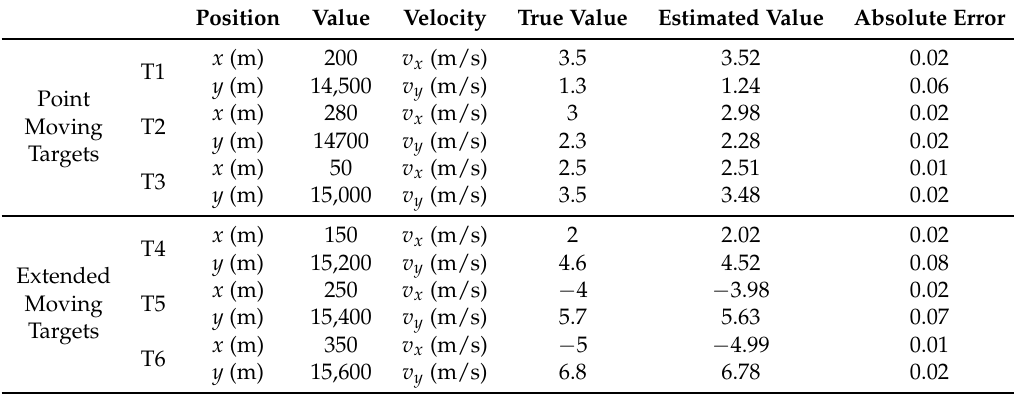
Table 2. 2D velocity estimation results. T, target.